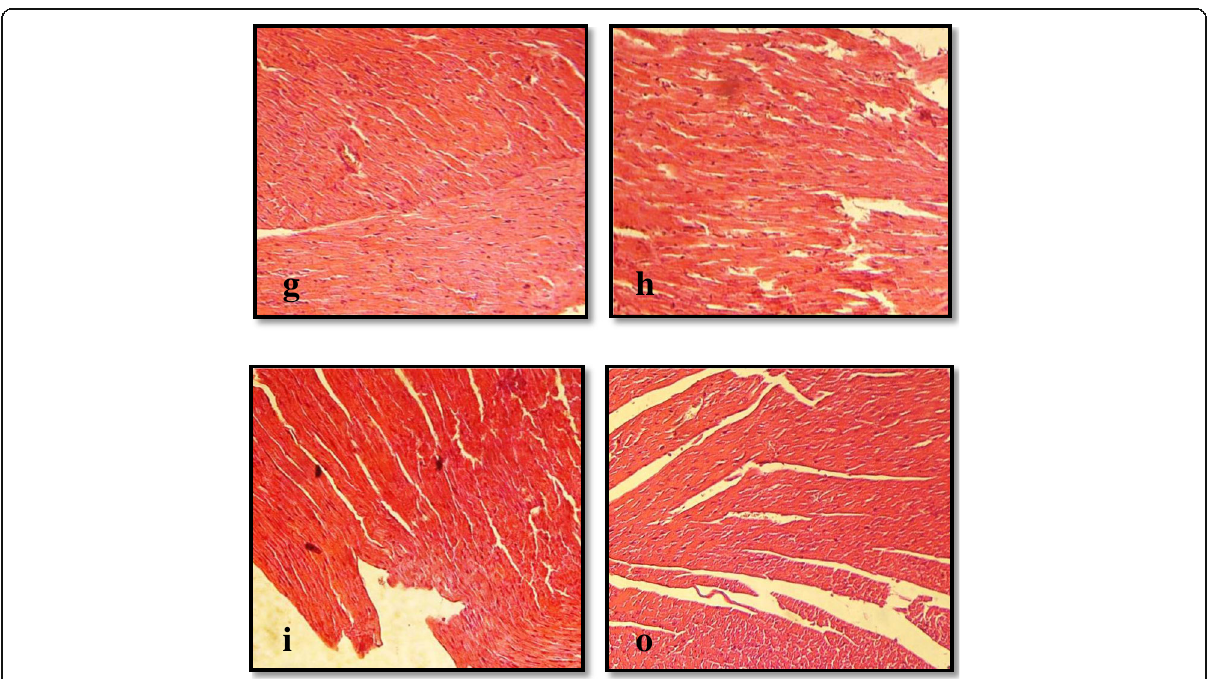
Fig. 3 Histopathology of the rat heart from different treated groups. g : Plant-treated group heart (250 mg/kg) showing the normal architecture of cardiac muscle. h : Plant-treated group heart (500 mg/kg) showing the normal architecture of cardiac muscle. i : Doxorubicin and plant-treated group heart (250 mg/kg) showing mild disruption of the cardiac muscle architecture. o : Doxorubicin and plant-treated group heart (500 mg/kg) preserved cardiac muscle